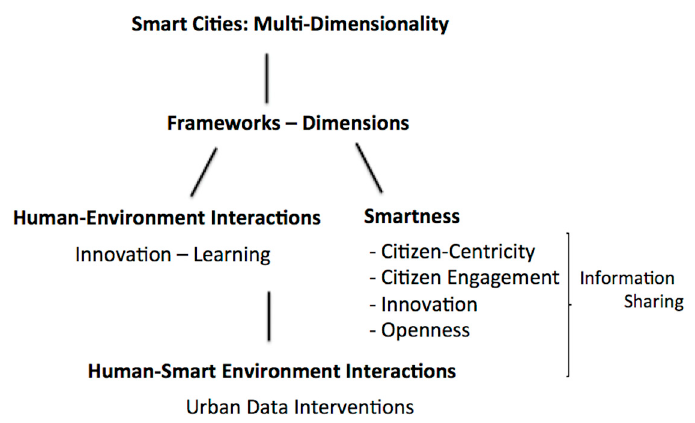
Figure 1. Categorization and organization of smart cities and multi-dimensionalities.